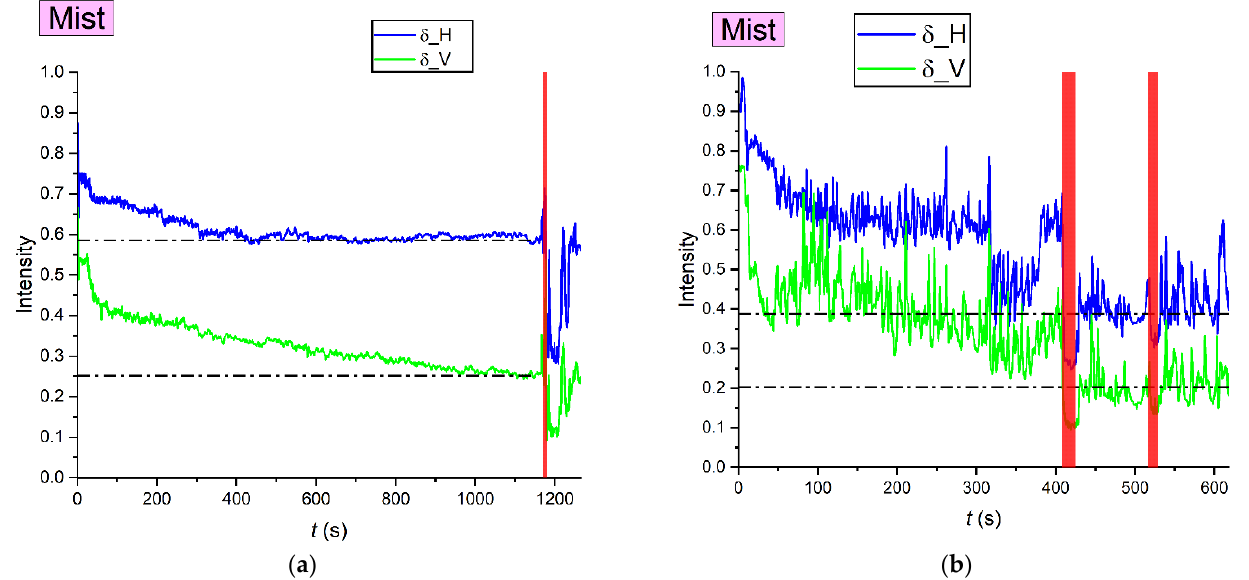
Figure 19. Changes in the parameter δ as the experimental setup space is filled with water mist: ( a ) water mist is released through the lower part of the setup; ( b ) water mist is released through the upper part of the setup.